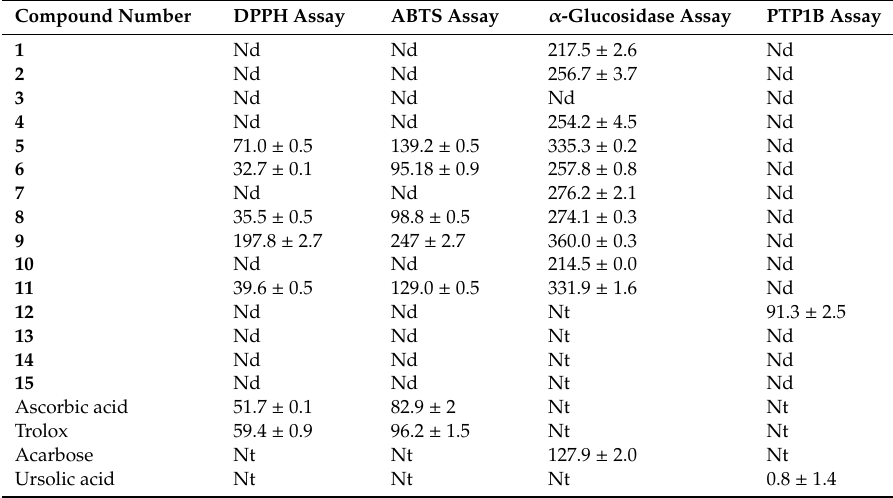
Table 1. IC 50 values of the bioassays of the compounds isolated from Nigella